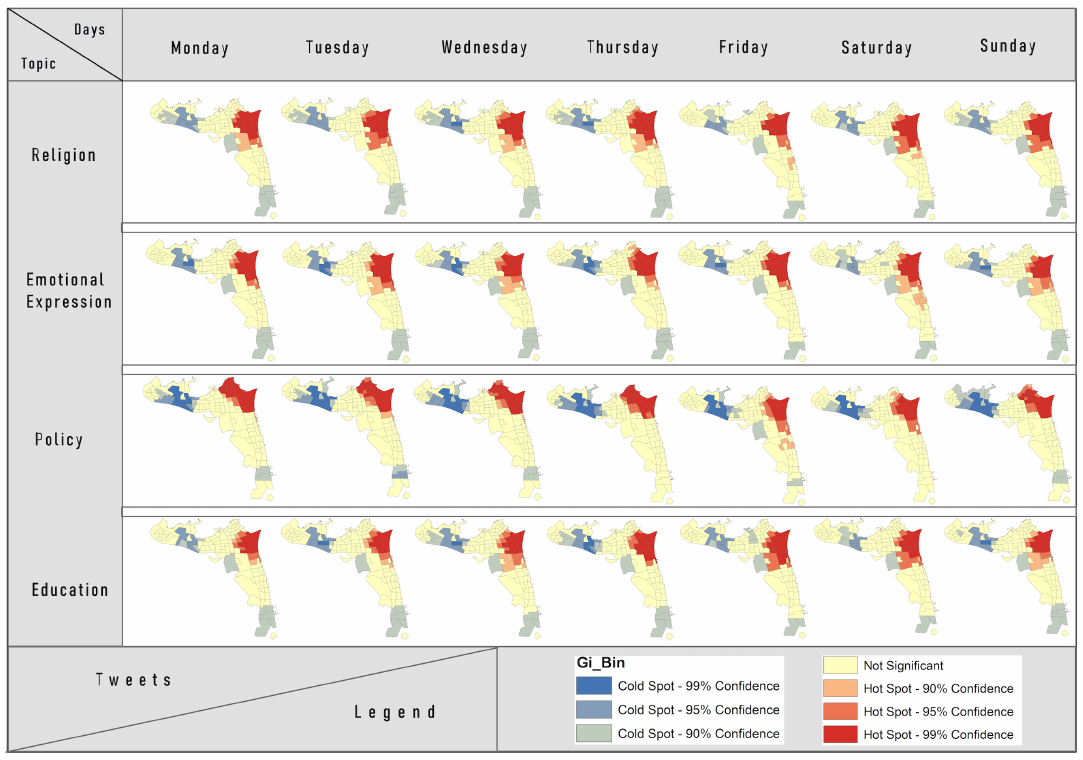
Figure 11. The distribution of hot spots and cold spots across for each day of the week in Kuwait’s urban